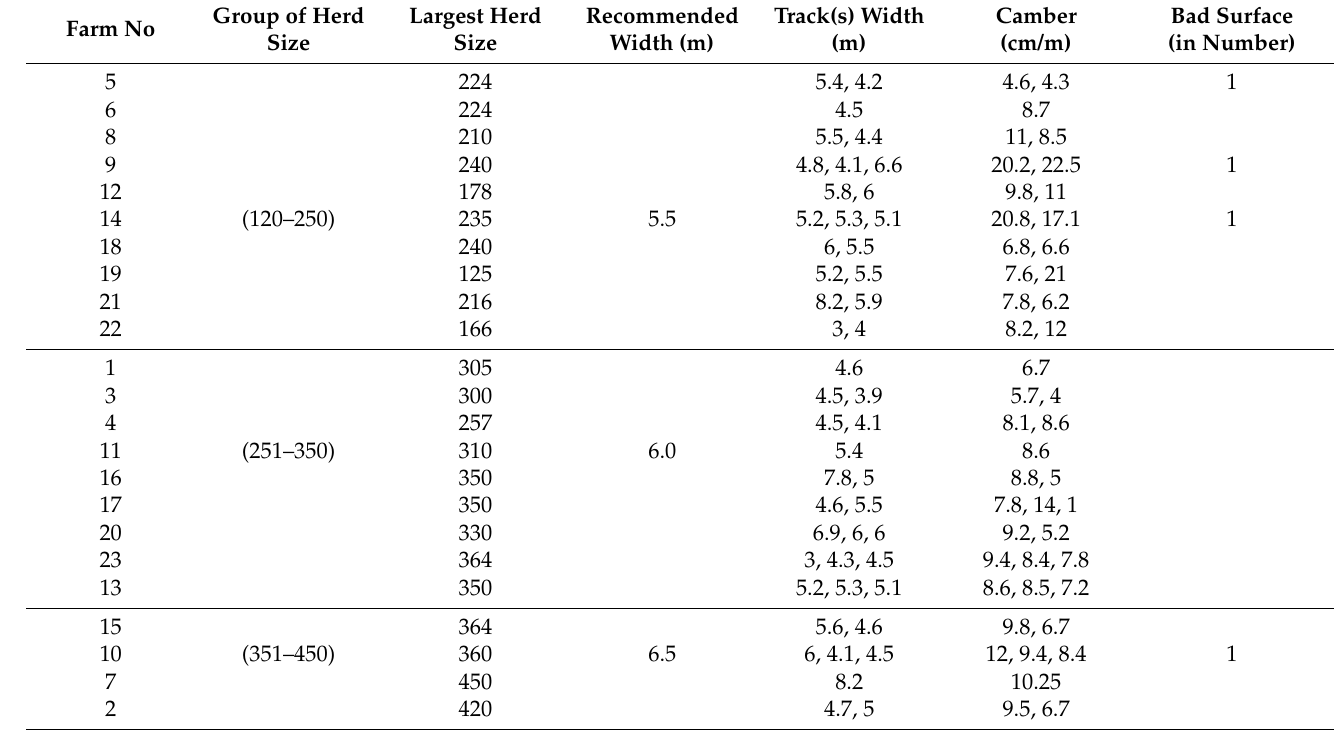
Table 7. Measurement of width, camber, and surface of the tracks leading to the parlour based on the largest herd size of the